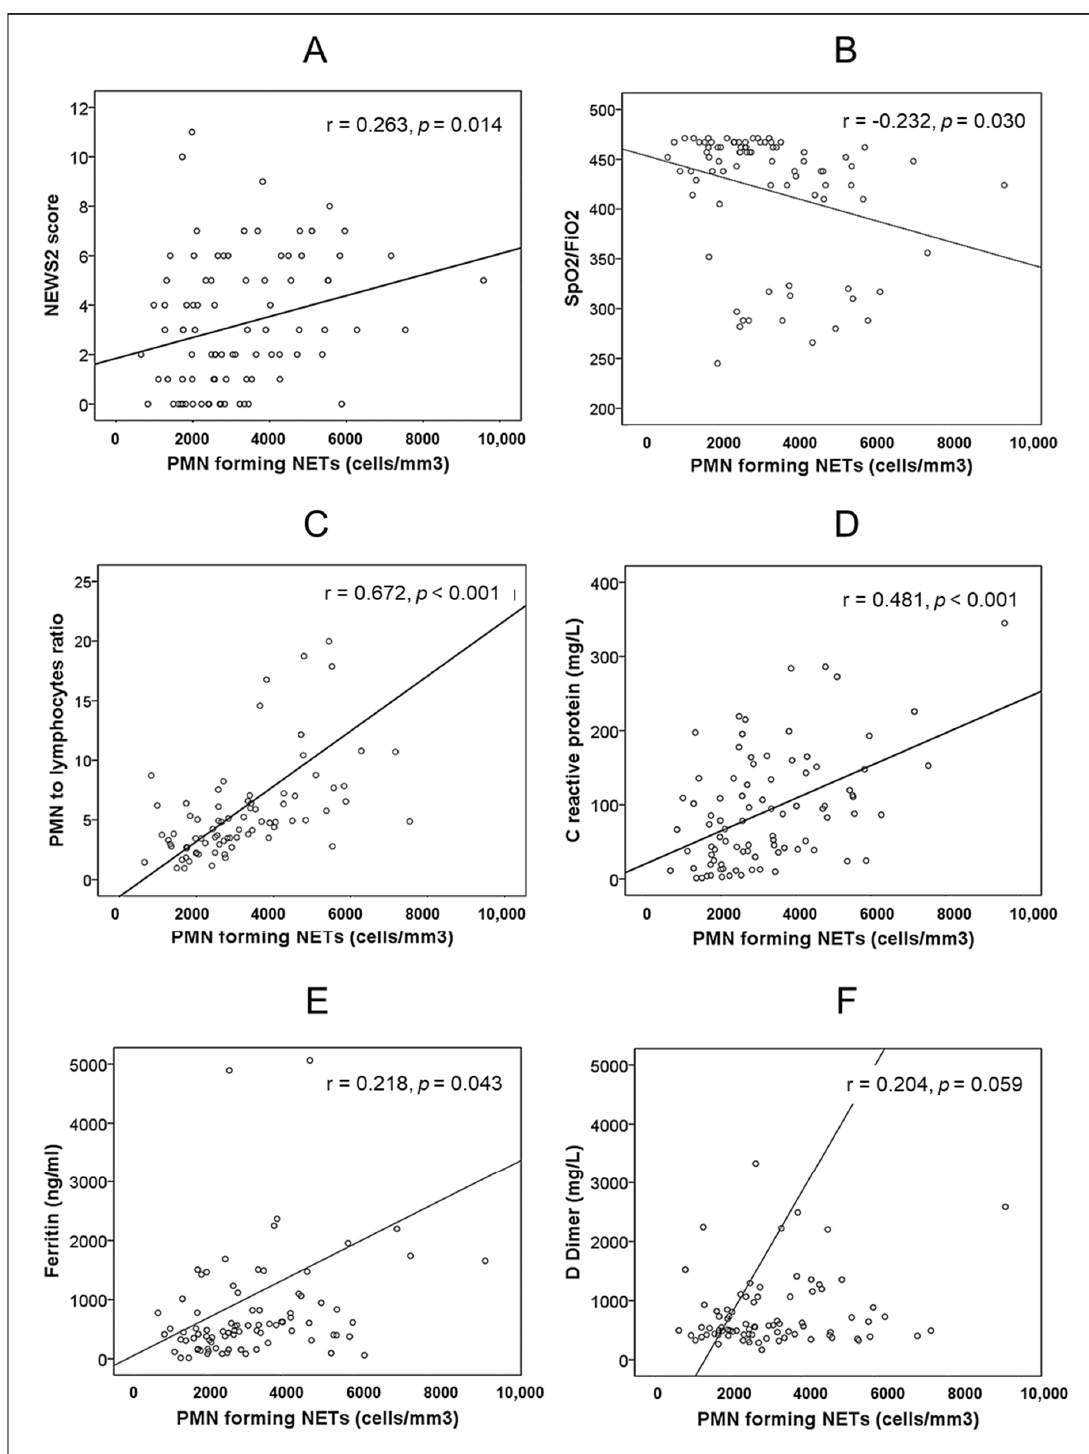
Figure 1. Bivariate correlations between absolute number of PMNs forming NETs and: ( A ) NEWS2 score. ( B ) SpO 2 /FiO 2 . ( C ) PMN to lymphocyte ratio. ( D ) Serum concentration of C-reactive protein. ( E ) Serum concentration of ferritin. ( F ) Plasma concentration of